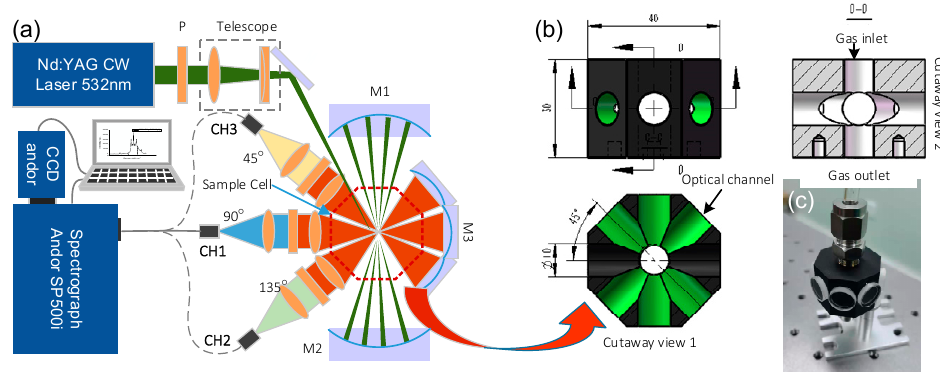
Figure 2. ( a ) Schematic of cavity-enhanced Raman spectrometer (CERS) prototype; ( b ) engineering drawing and cutaway view of the eight-sided cuvette; ( c ) image of the eight-sided cuvette. The samples used in this study were purchased from Yantai Deyi Gas Co. Ltd., China.